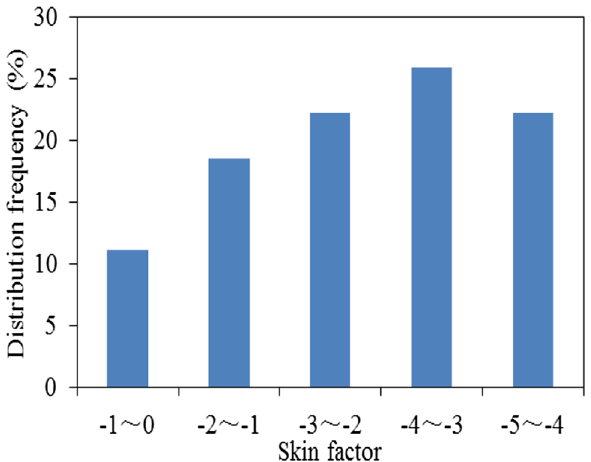
Fig. 2 Pressure changing range